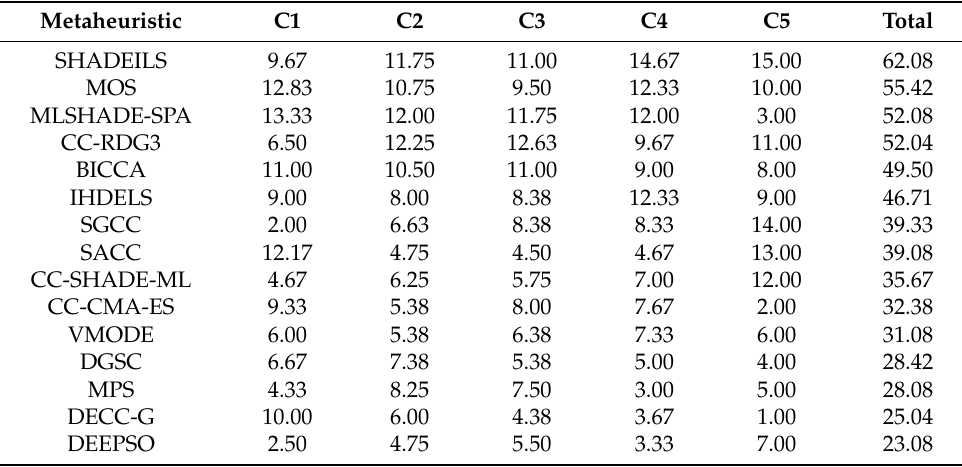
Figure 7. The self-adaptation curves for CC_size and pop_size of CC-tuned-k(7) in an independent run on: ( a , c , e , g )—CC-size for F 1 , F 4 , F 7 , F 15 and ( b , d , f , h )—pop-size for F 1 , F 4 , F 7 , F 15 . Table 9. The ranking of state-of-the-art metaheuristics.